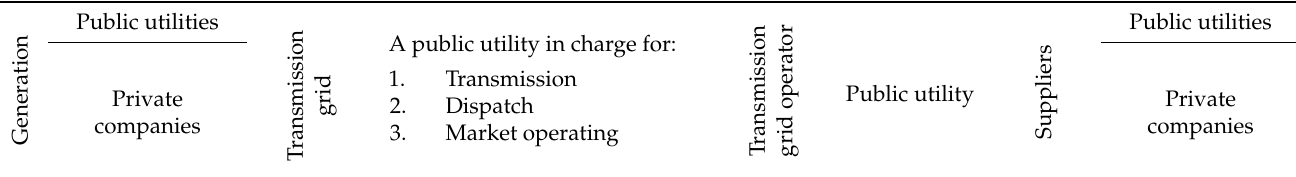
Table 14. Target energy market model [38].